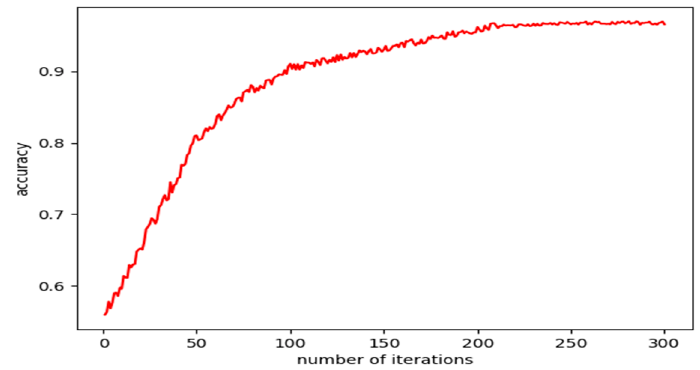
Figure 17. Relationship between the number of iterations and accuracy.